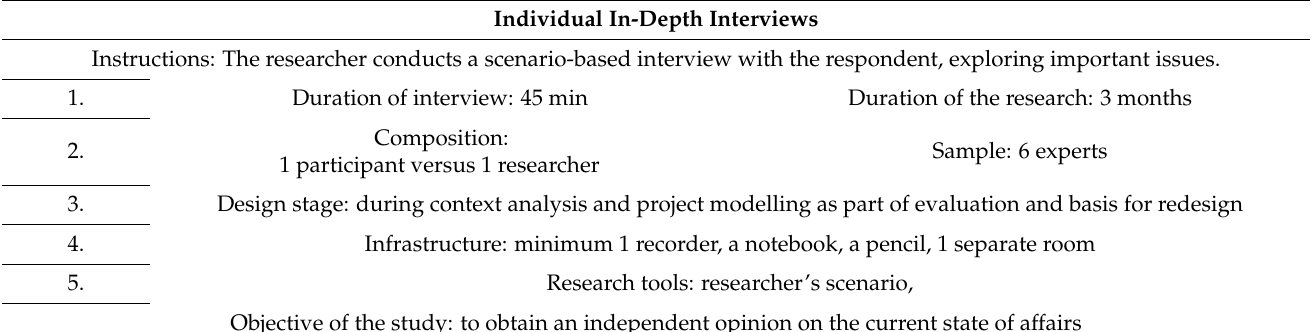
Table 3. Presentation of the semi-structured individual-in depth